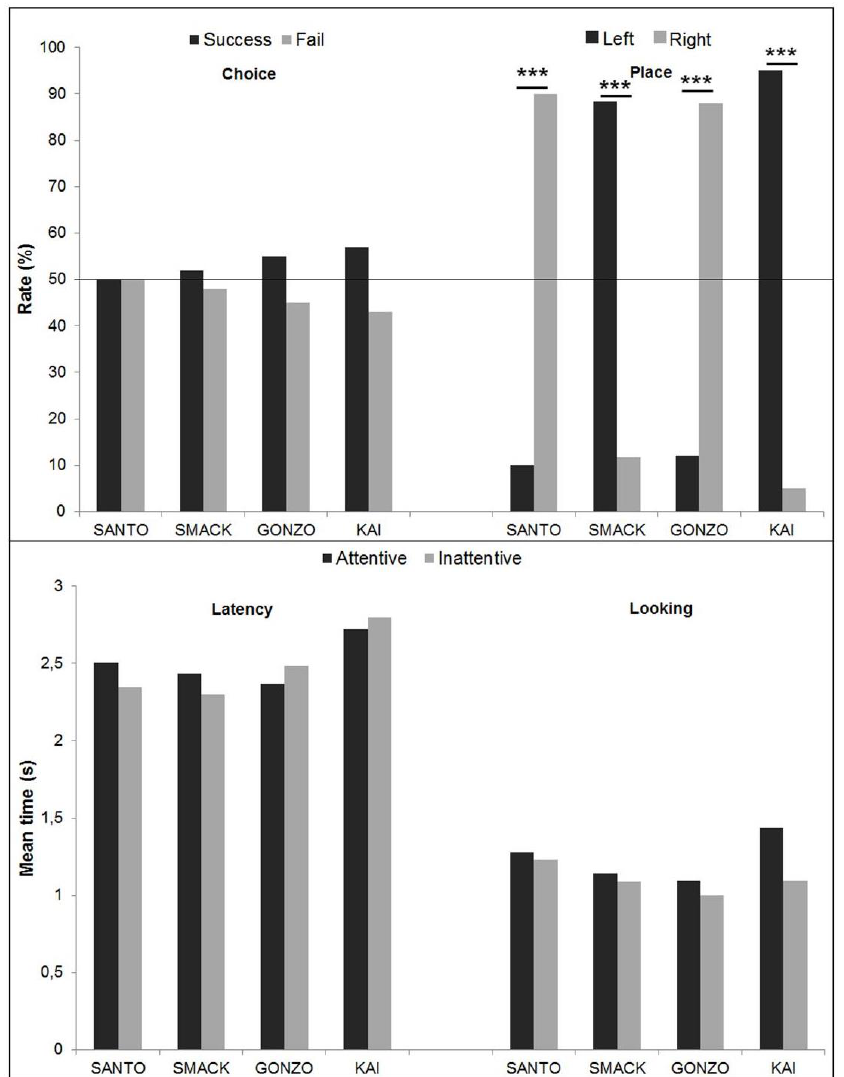
Figure 5 . Test 3: eye visibility. For each sea lion, Success / Failure rate and place (top) and mean time (s) of the response time (latency) and duration (s) of looking at the caretakers (down) during experiment 3. The line shows the random level with 50%. * = p<0.05; ** = p<0.01; *** =